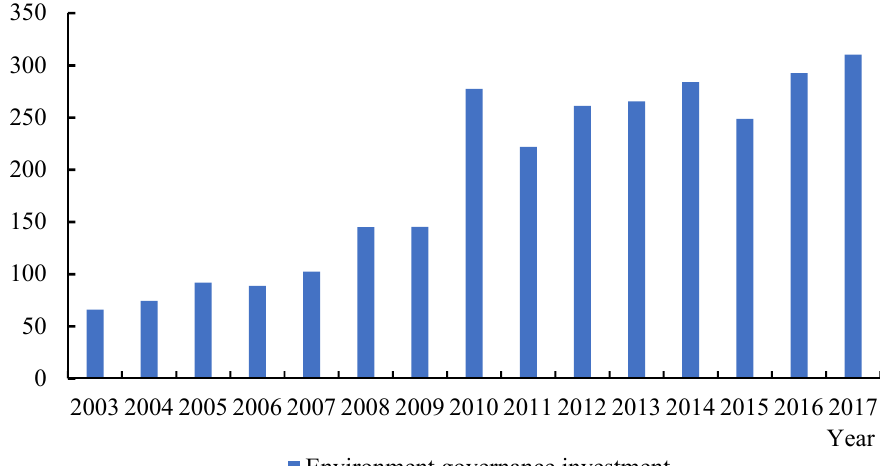
Figure 1. The average value of environmental governance investment in provinces where pilot FTZs are located. Source: China Statistical Yearbook on Environment,